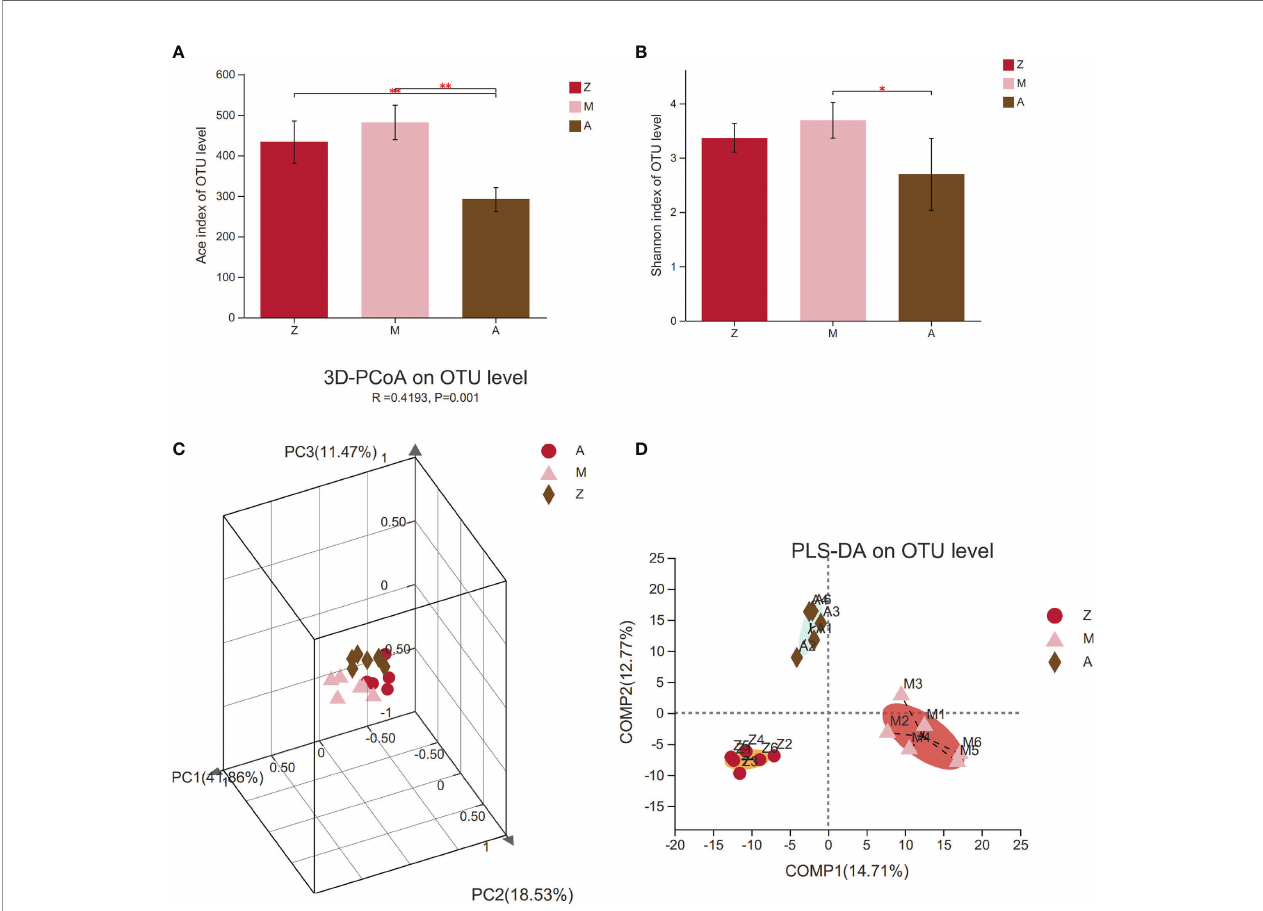
FIGURE 3 | Diversity of intestinal microbiota community. Z, control group; M, model group; A, treatment group. PCoA, principal coordinate analysis; PLS-DA, partial least squares discriminant analysis. (A) Ace index. (B) Shannon index. (C) PCoA. (D) PLS-DA.* p < 0.05; ** p <